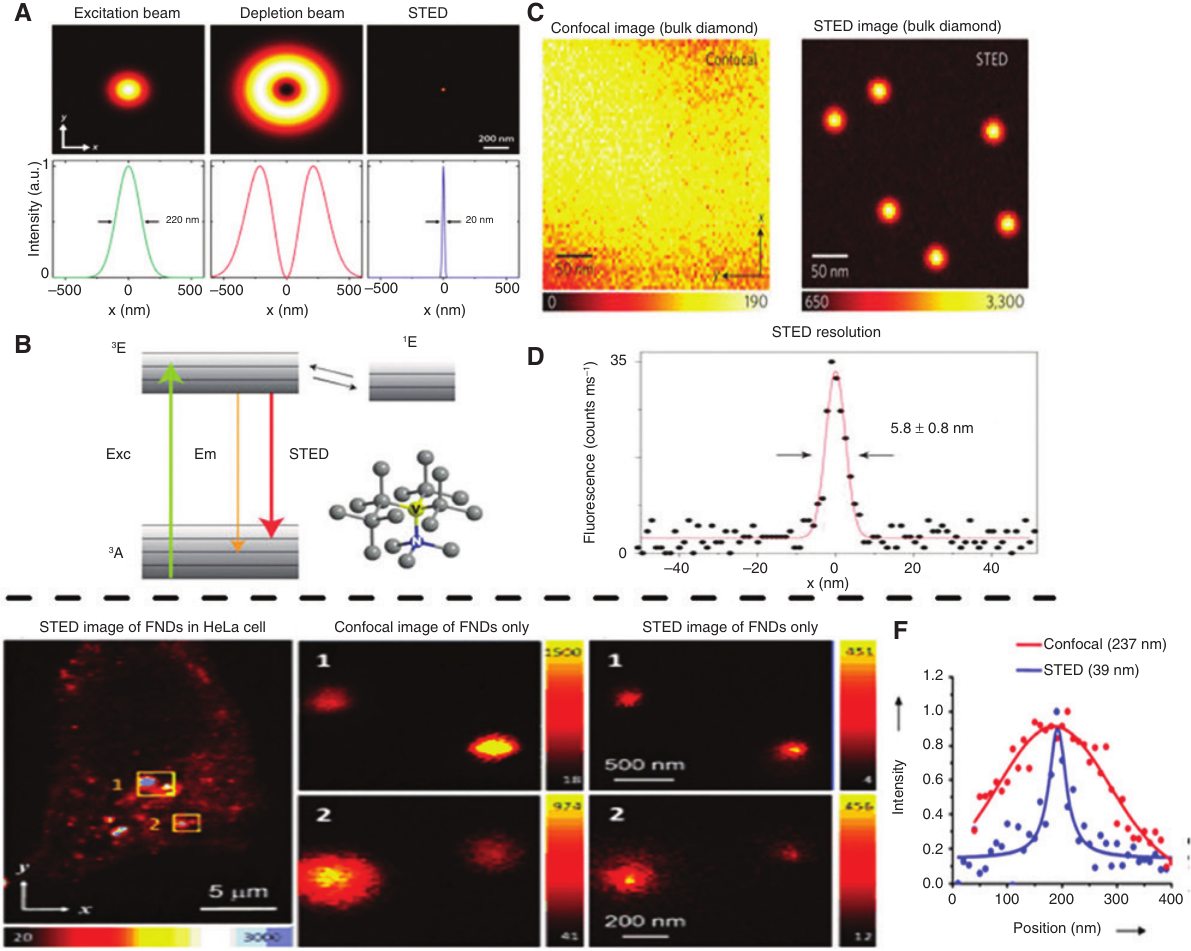
Figure 12: Applications of FNDs (NV center) in super-resolution imaging. (A) An illustration of STED microscopy technique. Adapted from [134]. (B) Energy levels of the triplet (left) and singlet states (right) of the NV center and the excitation beam (EXC), emission beam (Em), and stimulated emission (STED) transitions in nitrogen-vacancy centers. (C) Confocal and STED optical image of bulk diamond containing NV color centers. (D) STED high resolution for NV center in diamond, which reveals high spatial resolution reaching 5.8 ± 0.8 nm. Adapted from [135, 136]. (E) Confocal and STED imaging of HeLa cells labeled with BSA-conjugated FNDs through electroporation. STED images of single BSA-conjugated FND particles enclosed within the yellow boxes “1” and “2”. (F) Display of confocal and STED resolution of NV centers within diamond nanocrystals. Adapted from